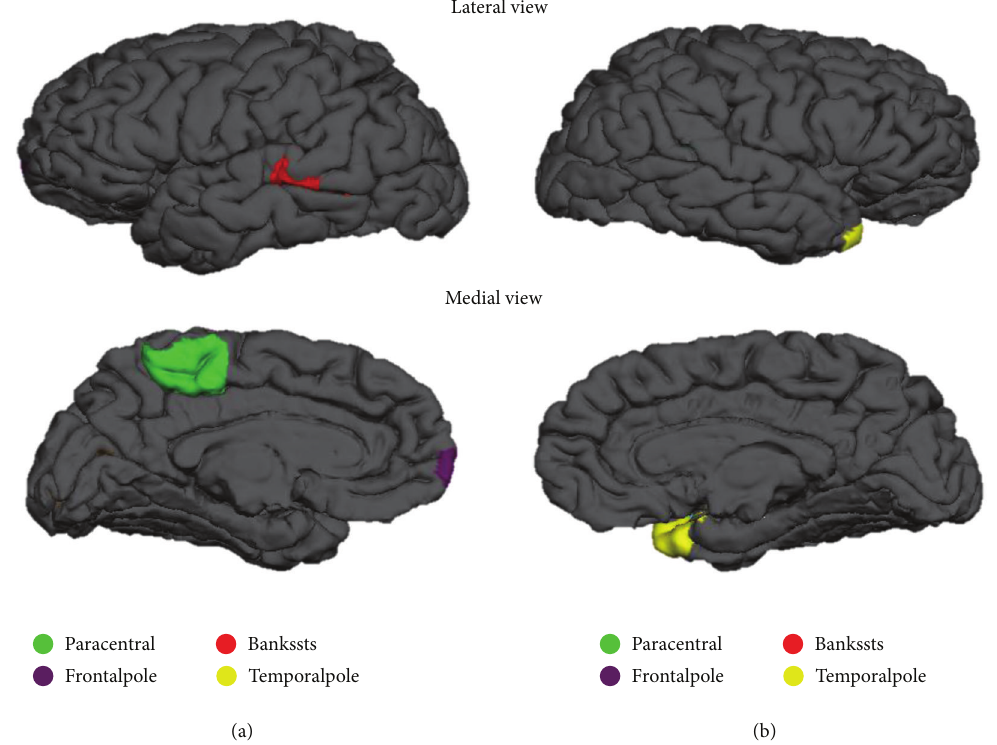
Figure 3: Representation of all significant surface area based on raw data in Table 7. (a) Left hemisphere (b) Right